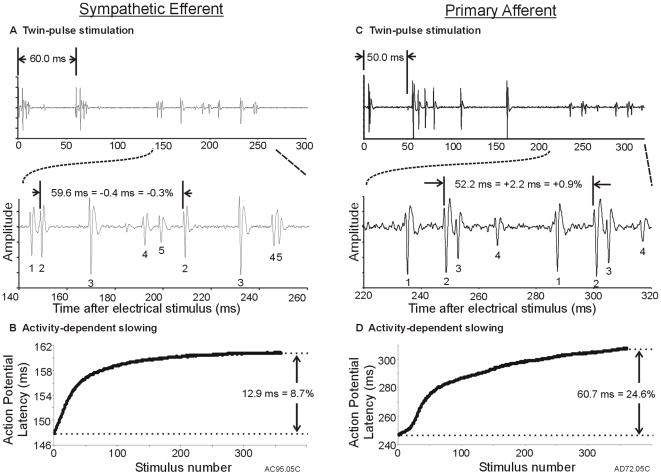
Typical results from a sympathetic efferent and a primary afferent.
A) Sympathetic efferent fiber exhibiting speeding of conduction to twin-pulse stimulation. Following an electrical twin pulse at the sciatic nerve (60 ms interstimulus interval), the conduction latency of the second action potential (AP) for fiber #2 was 0.4 ms smaller than for the first AP. Thus, the conduction velocity of the second AP increased (i.e., “speeding”). Top: Neuronal activity (total sweep length 300 ms) with stimulus artifacts at 60 ms. Bottom: Expanded view of neuronal activity showing five different AP waveforms. Fiber #2 originated from a sympathetic efferent (as identified by collision following electrical stimulation at the sympathetic chain). The other C fibers were not positively identified. B) Sympathetic efferent fiber shows little activity-dependent slowing. Following a train of electrical stimuli (2 Hz, 3 min), the conduction latency for fiber #2 increased by 12.9 ms or 8.7% relative to the latency for the first AP (148.6 ms, conduction velocity  = 1.0 m/s). C) The primary afferent fiber exhibited slowing of conduction to twin-pulse stimulation. Following electrical twin pulses at the sciatic nerve (50 ms interstimulus interval) the conduction latency of the second AP was 2.2 ms greater than that of the first. Thus, the conduction velocity of the second AP decreased (i.e., “slowing”). Top: Neuronal activity (total sweep length: 400 ms) showing stimulus artifact at 50 ms. Bottom: Expanded view of neuronal activity showing four different AP waveforms. Fibers #1–3 were all primary afferent fibers (as identified by collision following stimulation from the electrode on the dorsal root). D) The primary afferent fiber showed pronounced activity-dependent slowing. Following a train of electrical pulses applied at the sciatic nerve (2 Hz, 3 min), the conduction latency for fiber #2 increased by 60.7 ms or 24.6% relative to the latency for first AP (247.6 ms, conduction velocity  = 0.93 m/s).